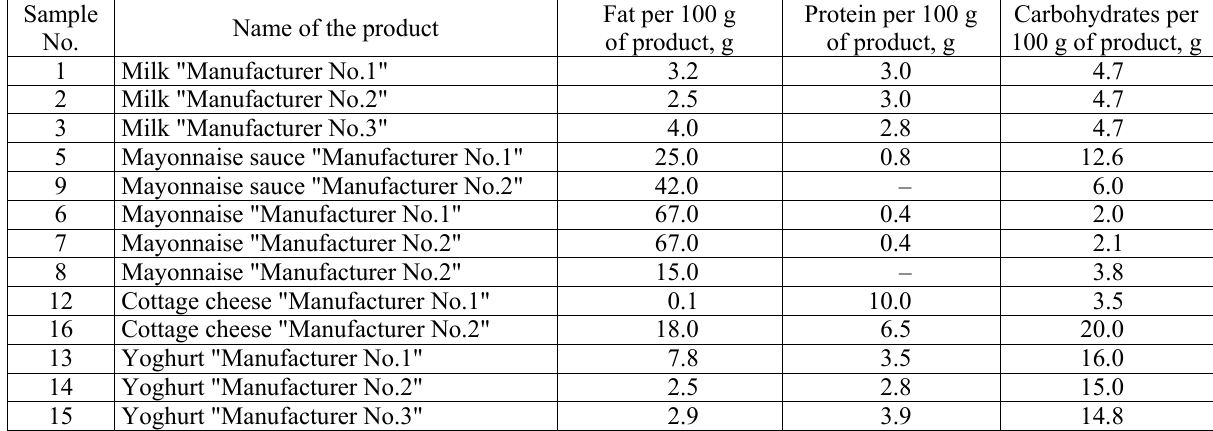
Table 1. Characteristics of the studied food products